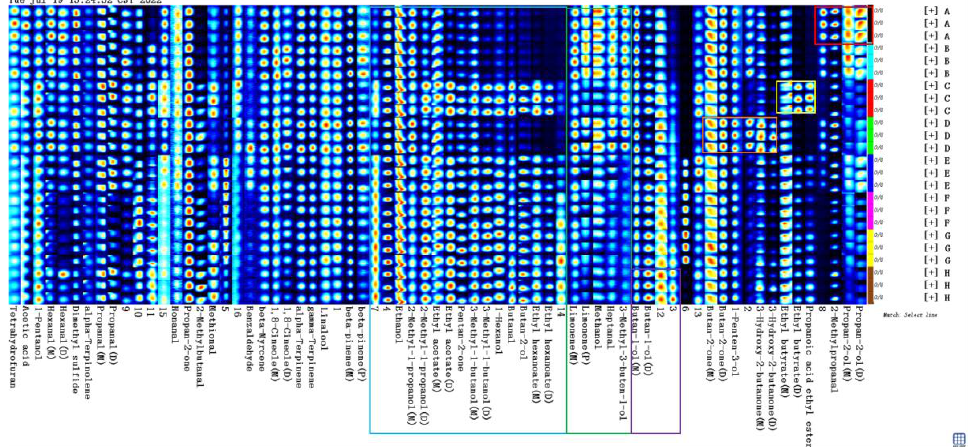
Figure 5. Global overview of the spots identified in the smoked sausage samples in the different treatment groups. treatment